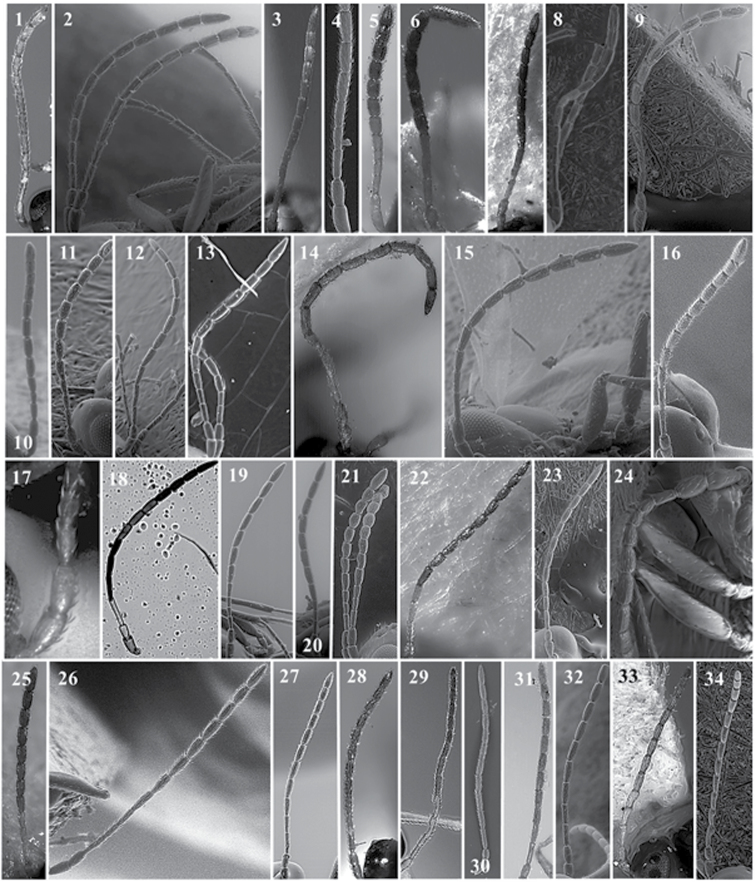
Alloxysta antennae. A.nothofagi (1); A.obscurata (2); A.pallidicornis (3); A.paretasmartinezi (4); A.patens (5); A.pedestris (6); A.piceomaculata (7); A.pilipennis (8); A.pilosa (9); A.pleuralis (10); A.postica (11); A.proxima (12); A.pusilla (13); A.quedenfeldti (14); A.ramulifera (15); A.rubidus (16); A.rufiventris (17); A.salicicola (18); A.sawoniewiczi (19); A.samurai (20); A.sarae (21); A.semiaperta (22); A.sharkey (23); A.slovenica (24); A.soluta (25); A.thorpei (26); A.torresi (27); A.tscheki (28); A.vandenboschi (29); A.victrix (30); A.xanthocera (31); A.xanthopa (32); A.xanthopsis (33); A.centroamericana (34).